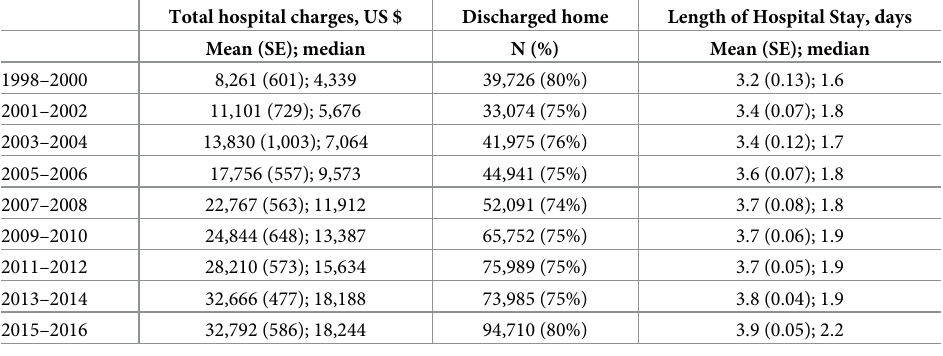
Table 4. Time-trends in healthcare utilization outcomes for OUD Hospitalizations from 1998 to 2016.